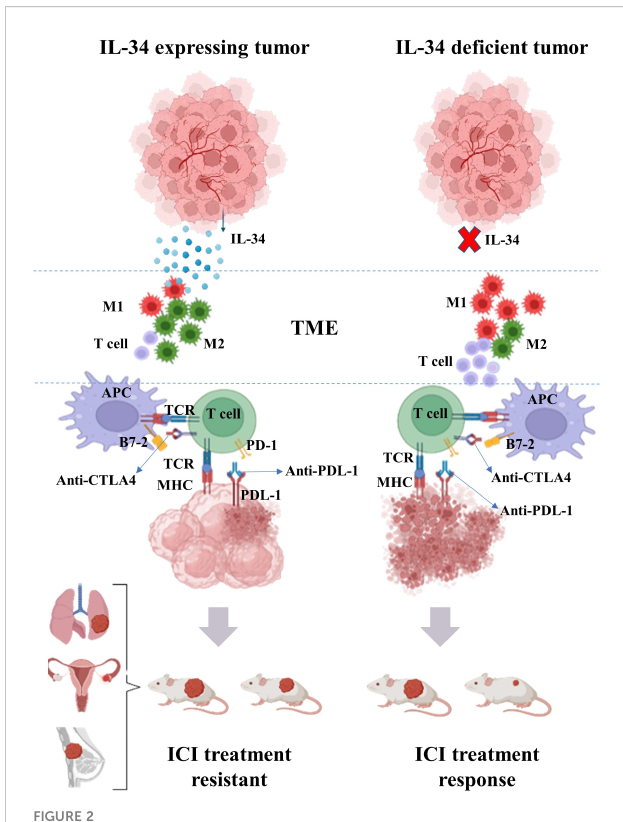
FIGURE 2 Overview of the effect of IL-34 on the ef fi cacy of immune checkpoint inhibitors (ICIs) in the treatment of cancer. Tumor-derived IL-34 can modulate the tumor microenvironments (TME) leading to lower frequency of T cell and increases in the ratio of M2-biased macrophages to M1-biased macrophages in TME. Conjunction with an ICI to treat malignancies, a neutralizing antibody directed against IL-34 increase the therapeutic bene fi ts of the